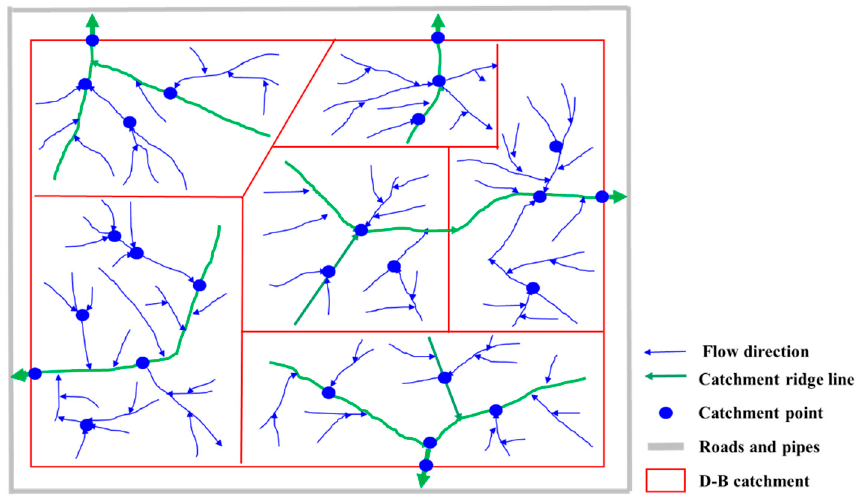
Figure 9. D-B (Direction-Based) catchment division.